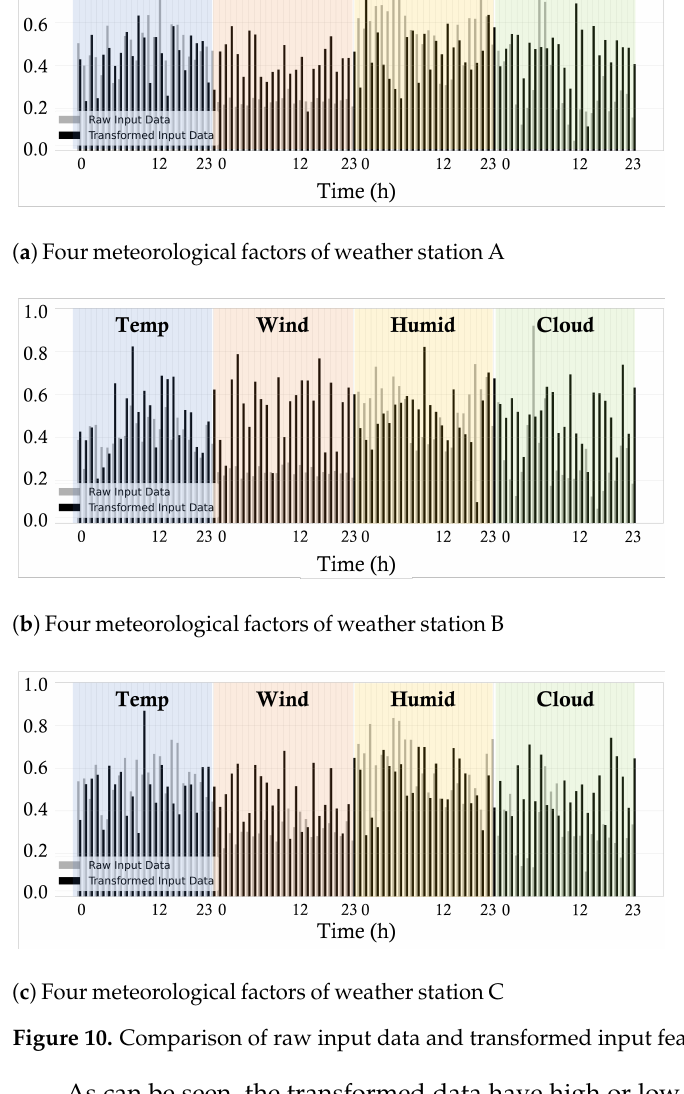
Figure 10. Comparison of raw input data and transformed input